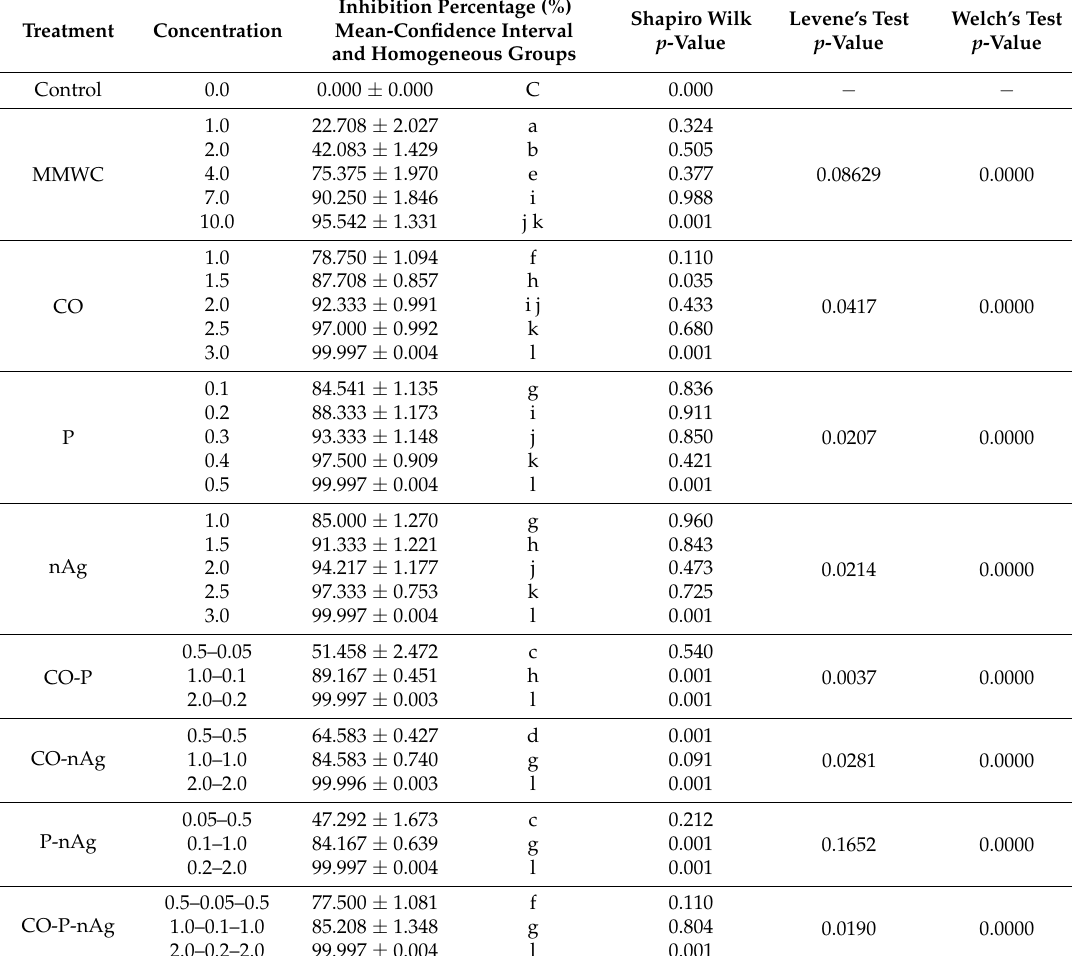
Table 2. Effect of treatment concentration on the mycelial growth of T. versicolor (in vitro) seven days after incubation. The concentrations of MMWC, COs and P are given in mg · mL − 1 , and that of nAg in µ g · mL − 1